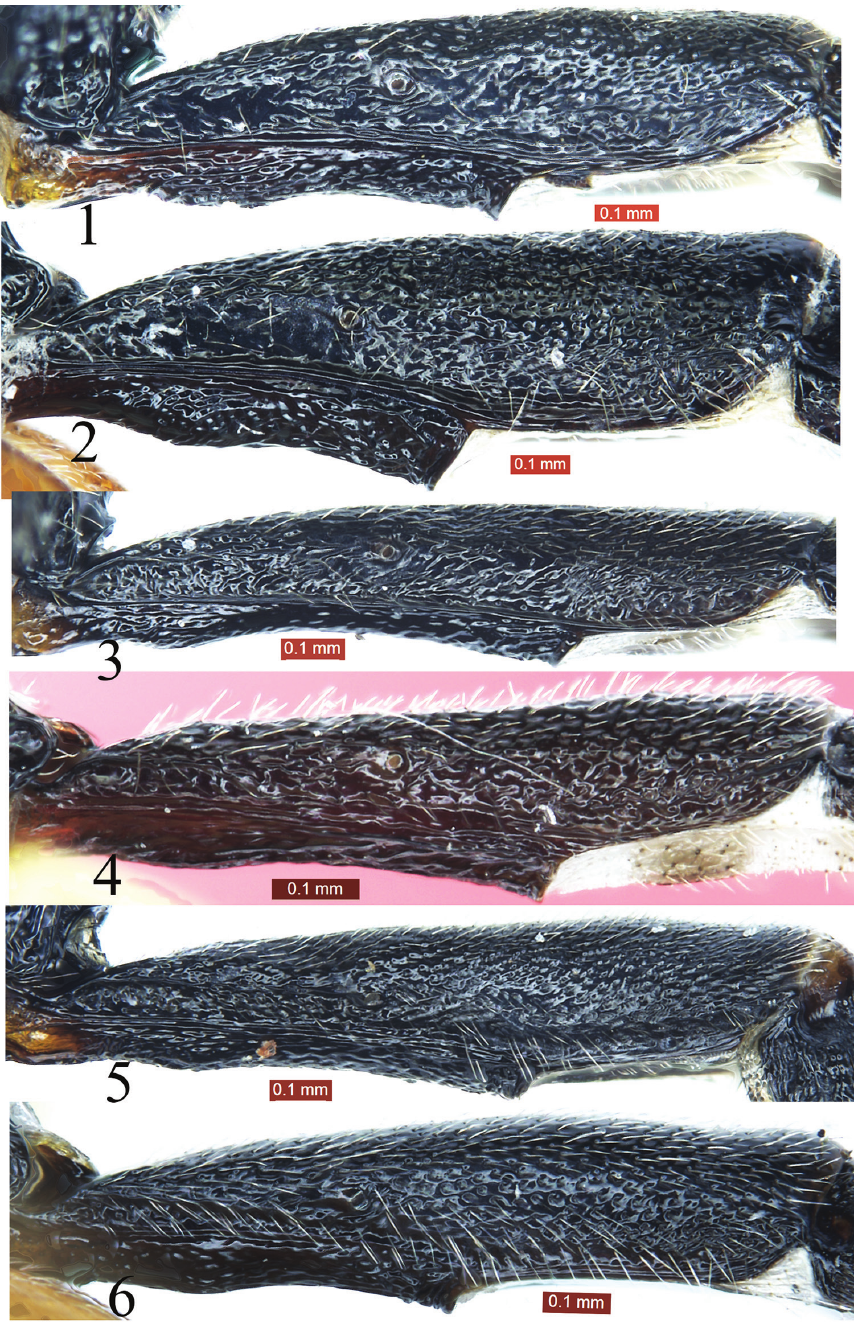
Figures 1–6. First tergites, lateral view. 1 Poemenia brachyura Holmgren, 1860 2 P . brevis Sheng & Sun, 2010 3 P . maculata Sheng & Sun, 2016 4 P . qinghaiensis Sheng & Sun, 2016 5 P . pedunculata He, 1996 6 P . quercusia Sun & Sheng, sp.